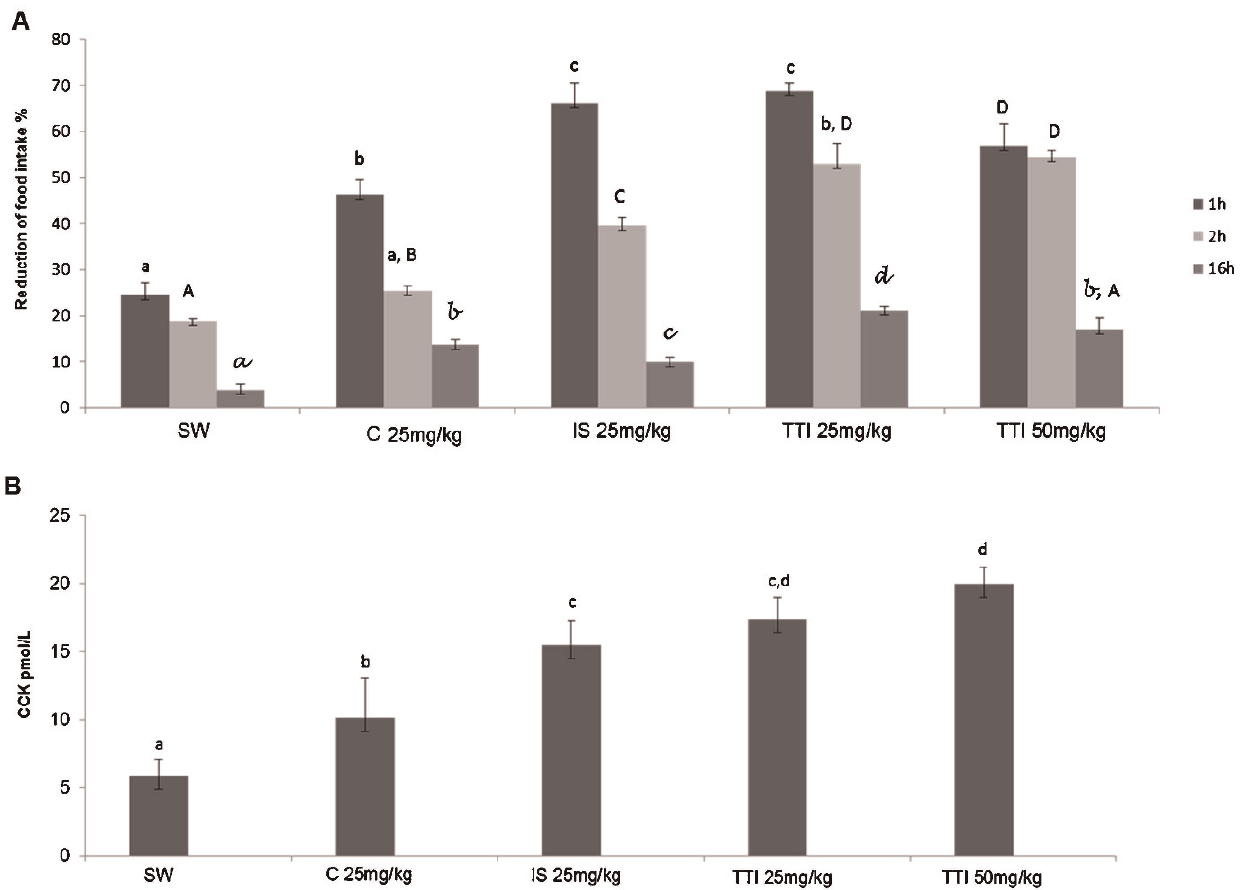
Figure 3 - Wistar rats were subjected to oral gavage using the AIN-93G standard diet + 1 mL of water (SW, n=6), AIN-93G + 25 mg/kg casein in 1 mL water (25 mg/kg C, n=6), AIN-93G + 25 mg/kg soybean trypsin inhibitor in 1 mL water (25 mg/kg IS, n=6), AIN- 93G + 25 mg/kg tamarind trypsin inhibitor in 1 mL water (25 mg/kg TTI, n=6) and AIN-93G + 50 mg/kg tamarind trypsin inhibitor in 1 mL water (50 mg/kg TTI, n=6) for 11 days. A) Food consumption (%) after 1 h, 2 h and 6 h of gavage in the studied groups. B) Plasmatic CCK levels after 1 h of gavage in the studied groups. The results are expressed as the mean ¡ standard deviation of each group. Different letters indicate p , 0.05 using one-way ANOVA and Tukey’s